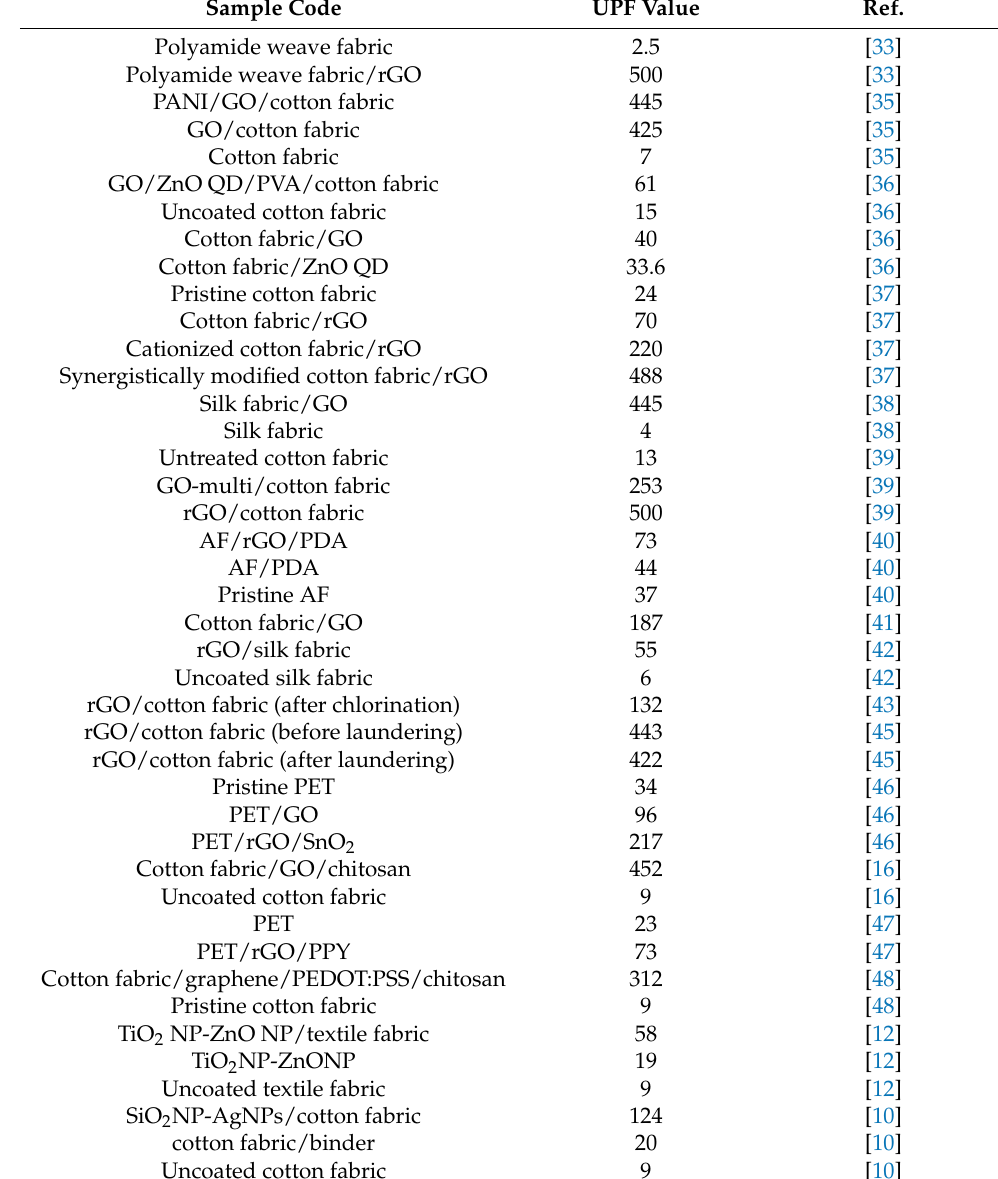
Table 1. UPF values for different material-based coated textile fabrics (Based on literature the general uncertainty value of UPF value is ± 3%. Additionally, equal to or more than 50 is excellent UPF value. Sample